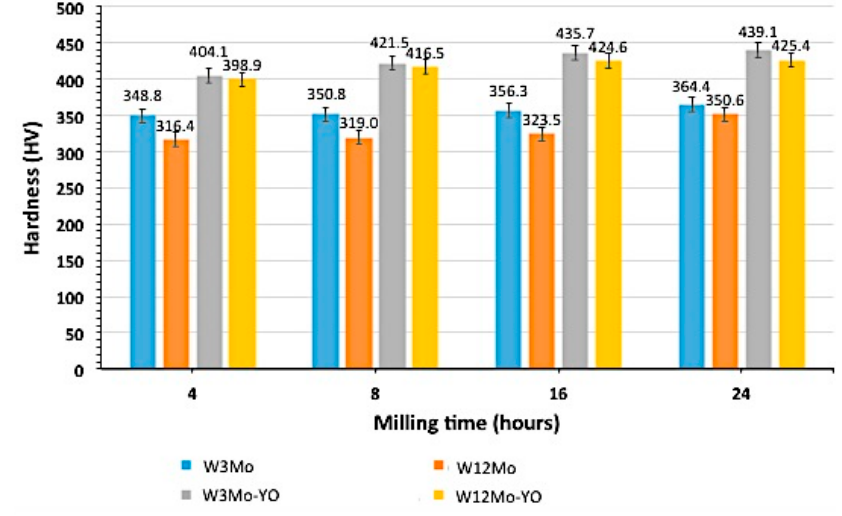
Figure 8. The microhardness of the model alloys at different durations of milling.